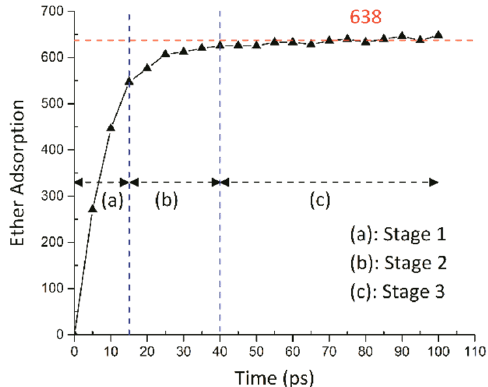
Figure 13. The number of ether molecules adsorbed on double sphere model.